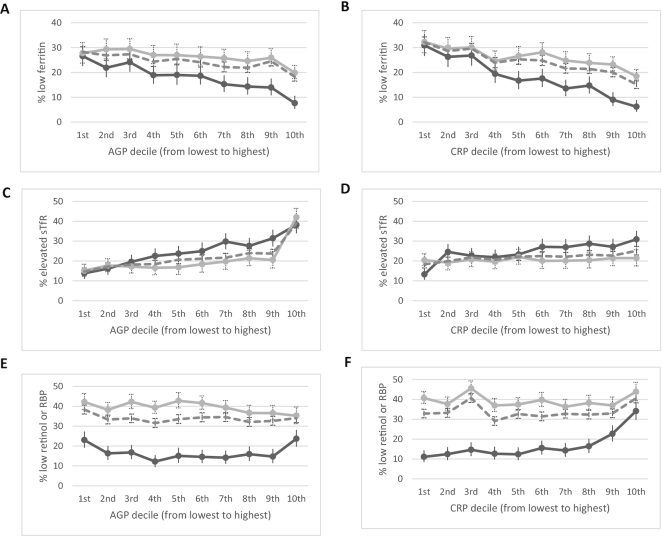
Estimated prevalence [% (95% CI)] of depleted iron stores, iron-deficient erythropoiesis, and vitamin A insufficiency by inflammation deciles in women, BRINDA project. Estimated prevalence of depleted iron stores by AGP deciles (A) and CRP deciles (B), iron-deficient erythropoiesis by AGP deciles (C) and CRP deciles (D), and vitamin A insufficiency by AGP deciles (E) and CRP deciles (F) in women. Depleted iron stores defined as ferritin <15 µg/L, iron-deficient erythropoiesis as sTfR >8.3 mg/L, and vitamin A insufficiency as either retinol or RBP <1.05 µmol/L. Dashed line, pooled BRINDA phase 1 and 2 data; dark gray line, BRINDA phase 1 data; and light gray line, BRINDA phase 2 data. Sample size: (A, B) 4352 for BRINDA phase 1, 13,719 for BRINDA phase 2, and 18,071 for BRINDA pooled; (C, D) 5098 for BRINDA phase 1, 10,775 for BRINDA phase 2, and 15,873 for BRINDA pooled; (E, F) 4285 for BRINDA phase 1, 13,354 for BRINDA phase 2, and 17,639 for BRINDA pooled. AGP, α-1-acid glycoprotein; BRINDA, Biomarkers Reflecting Inflammation and Nutritional Determinants of Anemia; CRP, C-reactive protein; RBP, retinol-binding protein; sTfR, soluble transferrin receptor.